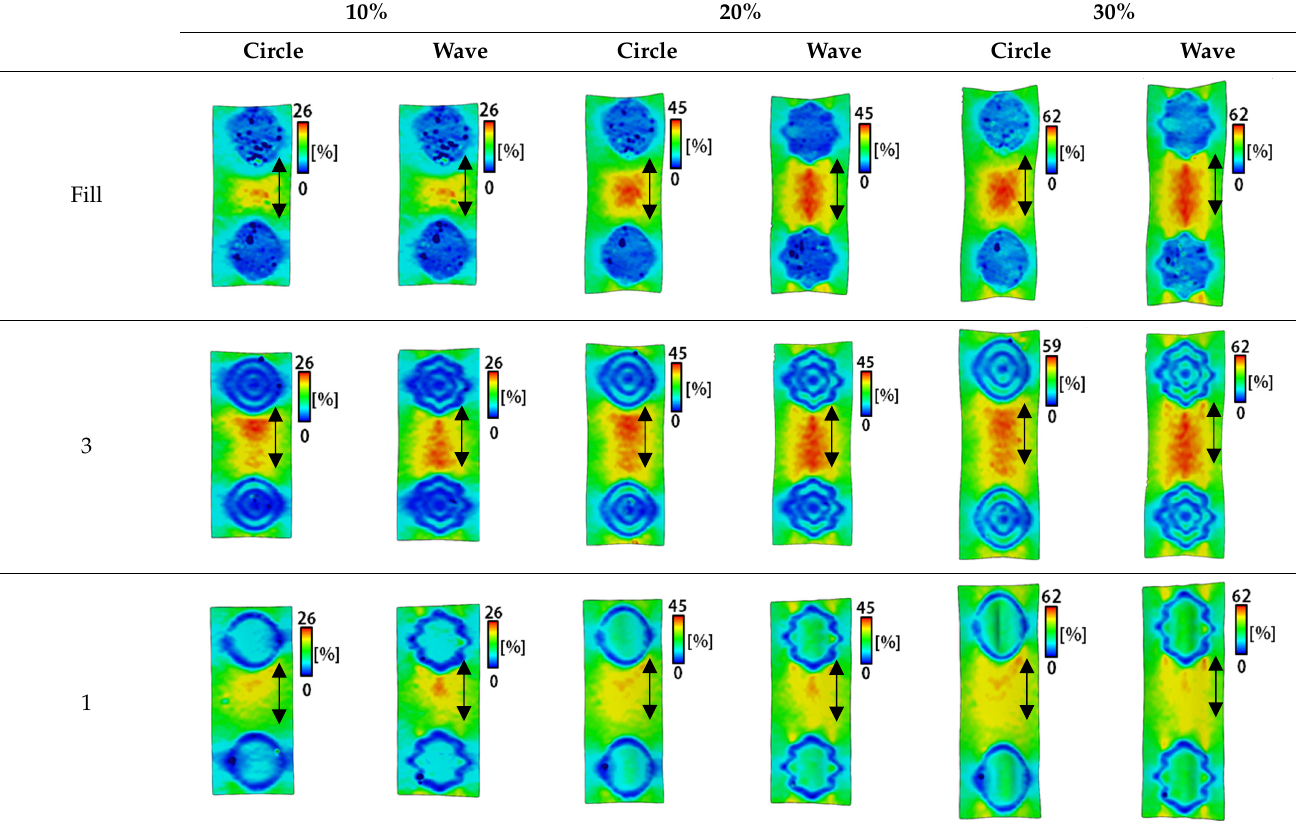
Table 4. DIC images of the bipolar embroidery-based textile electrodes by tensile change.